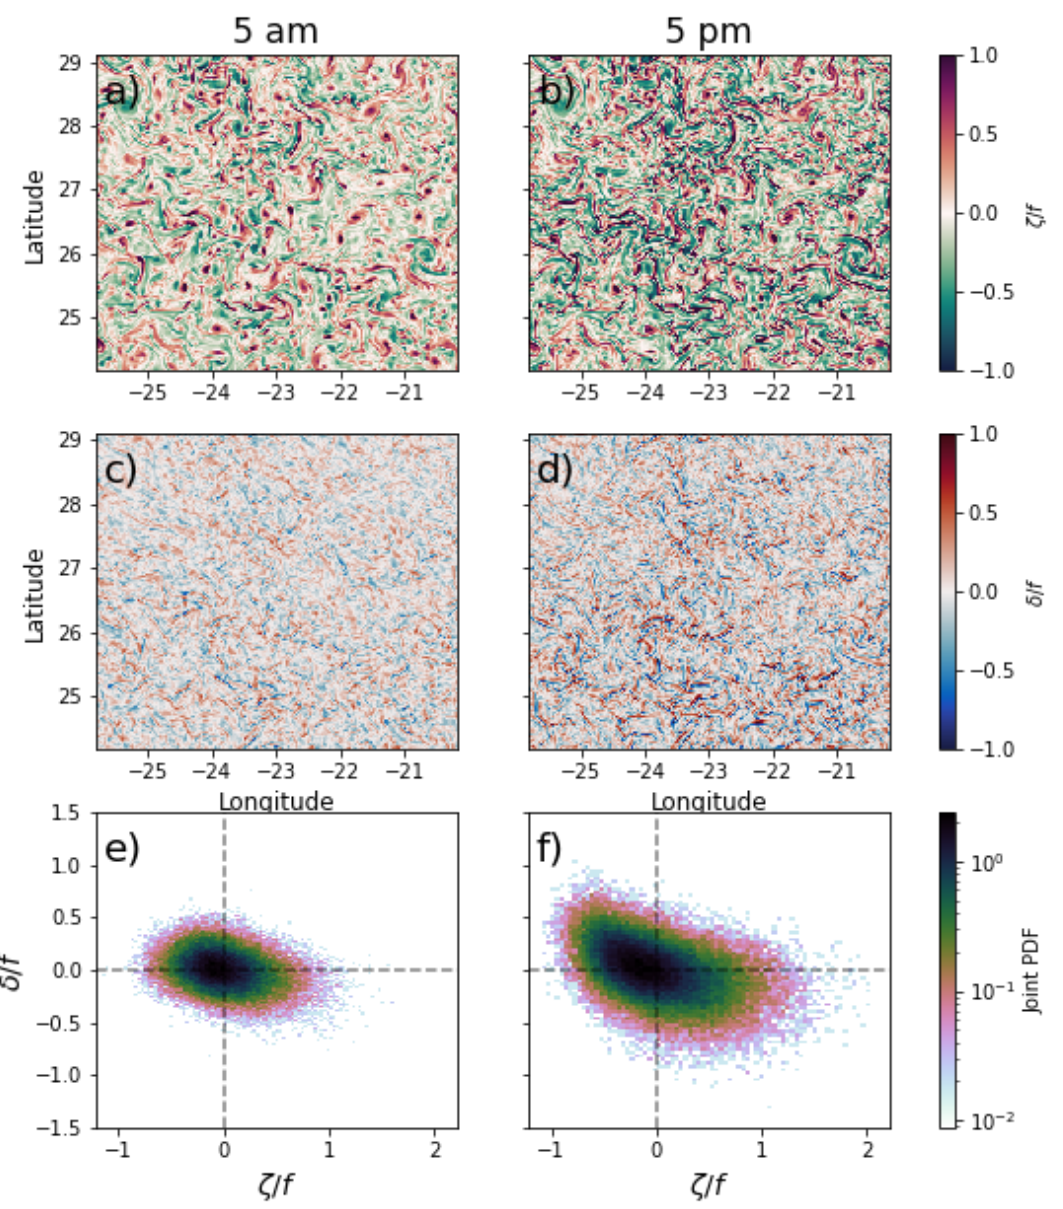
Figure 5. Snapshots of the relative vorticity ( ζ : ( a , b )), divergence ( δ : ( c , d )), and instantaneous ζ - δ joint probability distributions ( e , f ) at Canary (26.64 ◦ N) for times where the sea surface temperature was maximal (at around 5:00 p.m. local time, left) and minimal (at around 5:00 a.m. local time, right) on an arbitrary day in winter (1 March 2012). Joint PDF colors are presented on a logarithmic